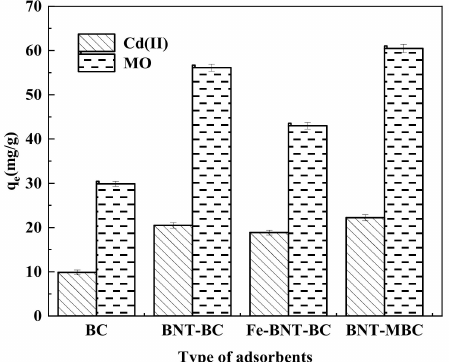
Figure 3. Adsorption capacity of Cd(II) and MO by different types of adsorbents (adsorbent dose 20 mg, contaminant solution 10 mL, pH 6, constant temperature 25 ◦ C, and reaction time 24